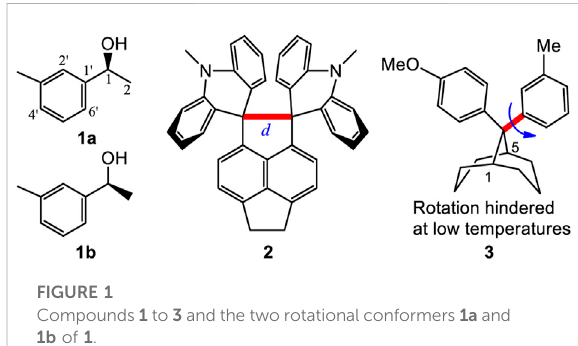
FIGURE 1 Compounds 1 to 3 and the two rotational conformers 1a and 1b of 1